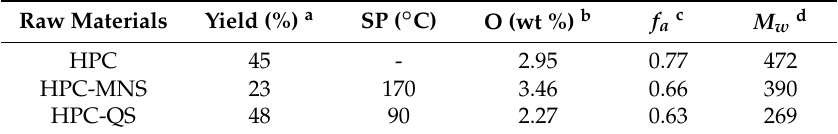
Table 1. Characteristics of the raw